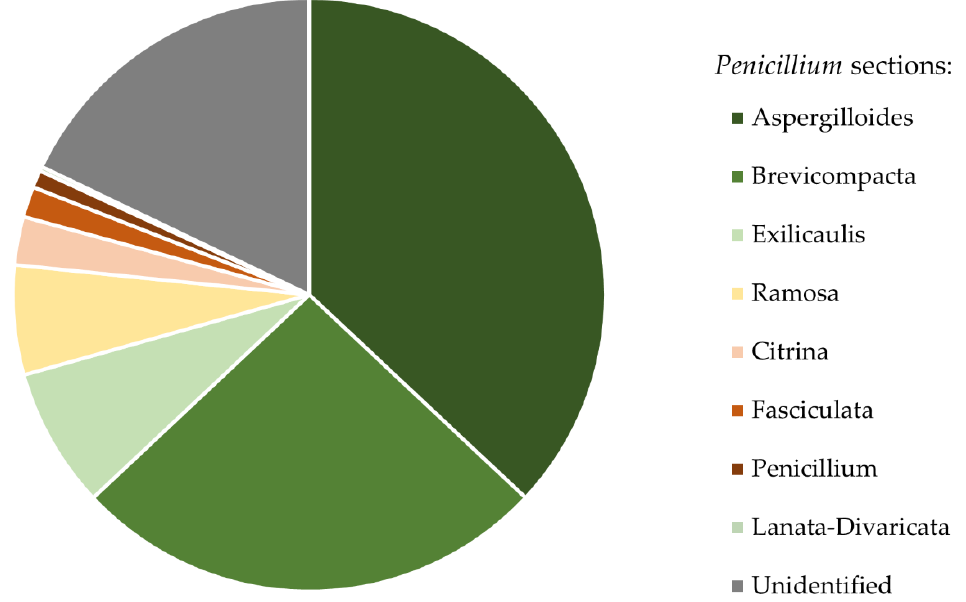
Figure 3. Relative abundance of Penicillium strains belonging to different sections, isolated from bodies of F. polyctena ants.